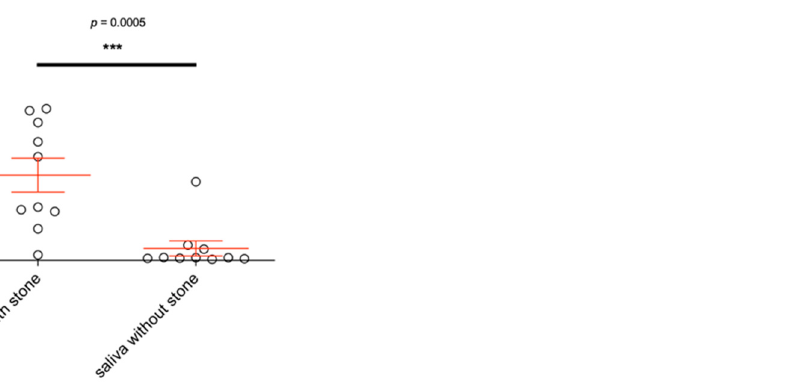
Figure 6. Representation of the different MUC8 concentrations of saliva samples from submandibular glands with and without salivary stone in the excretory duct system. The concentration of MUC8 is indicated in ng/mL. There is a statistically highly significant difference in MUC8 concentration of saliva with salivary stone ( n = 10) as opposed to without salivary stone (“healthy”, n = 10, p ≤ 0.0005). MUC8 is significantly increased in salivary glands with stone in the excretory duct system. (*** p < 0.001).